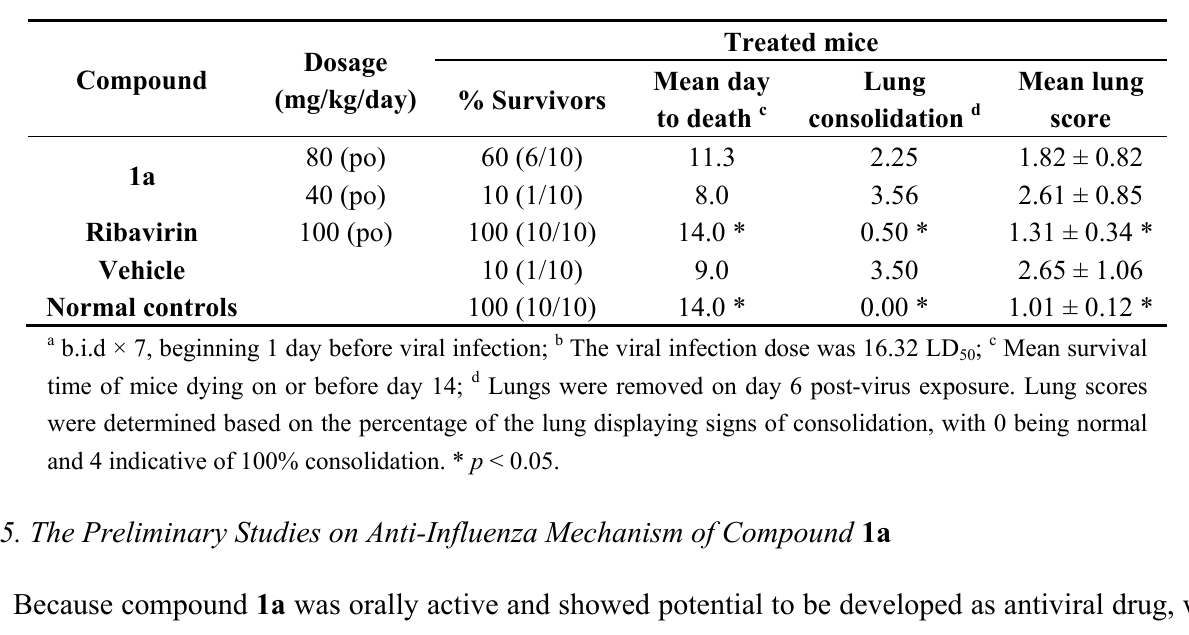
Table 3. Effects of oral treatment a with 1a on influenza A/FM/1/47-MA (H1N1) virus infections b in